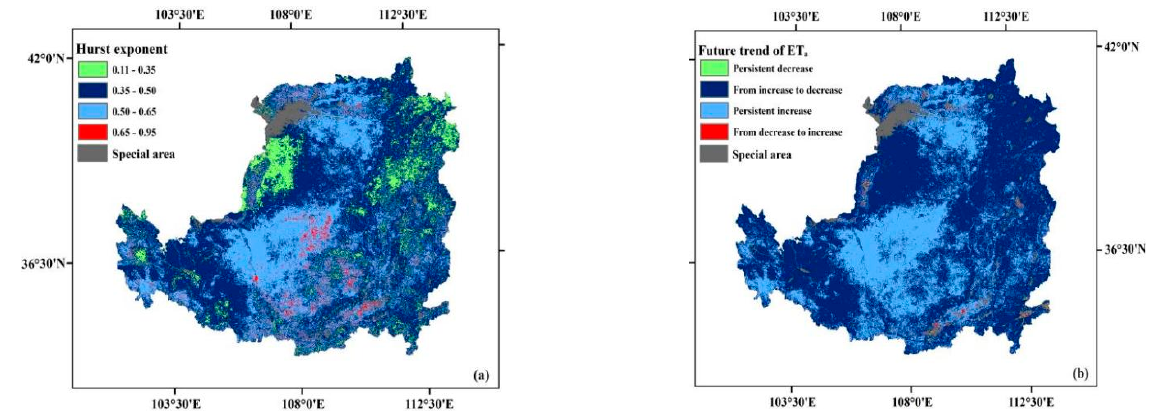
Figure 8. Hurst exponent ( a ) and future trend of ET a ( b ) in the